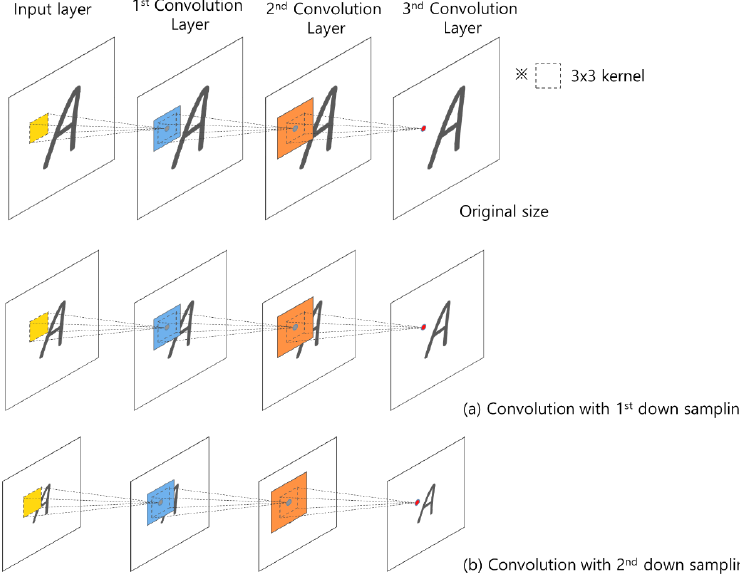
Figure 6. Influence area of the convolution product according to the size of the 2D